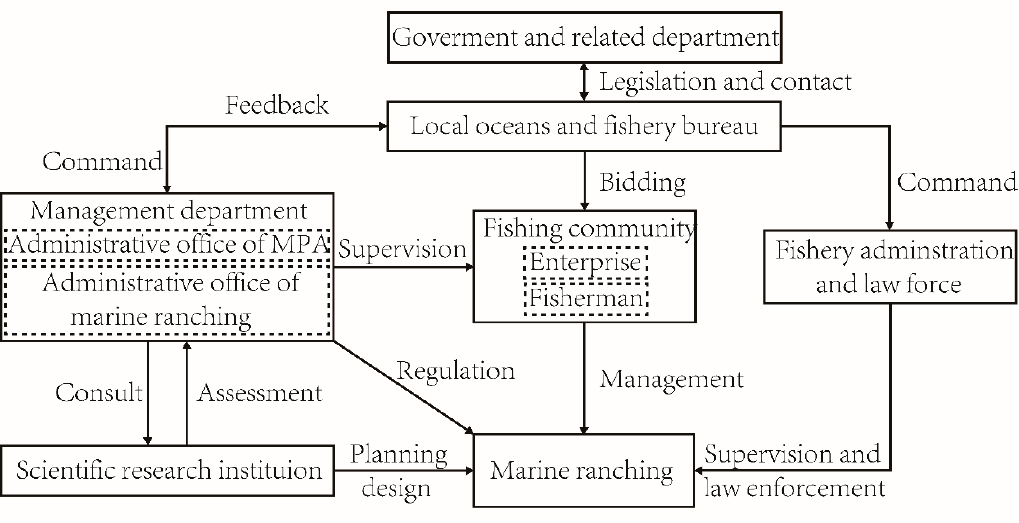
Figure 7. Regulatory system and relationships between stakeholders in the Ma’an marine ranching pilot. Table 2. Management tools and measures for the different components of marine ranching.